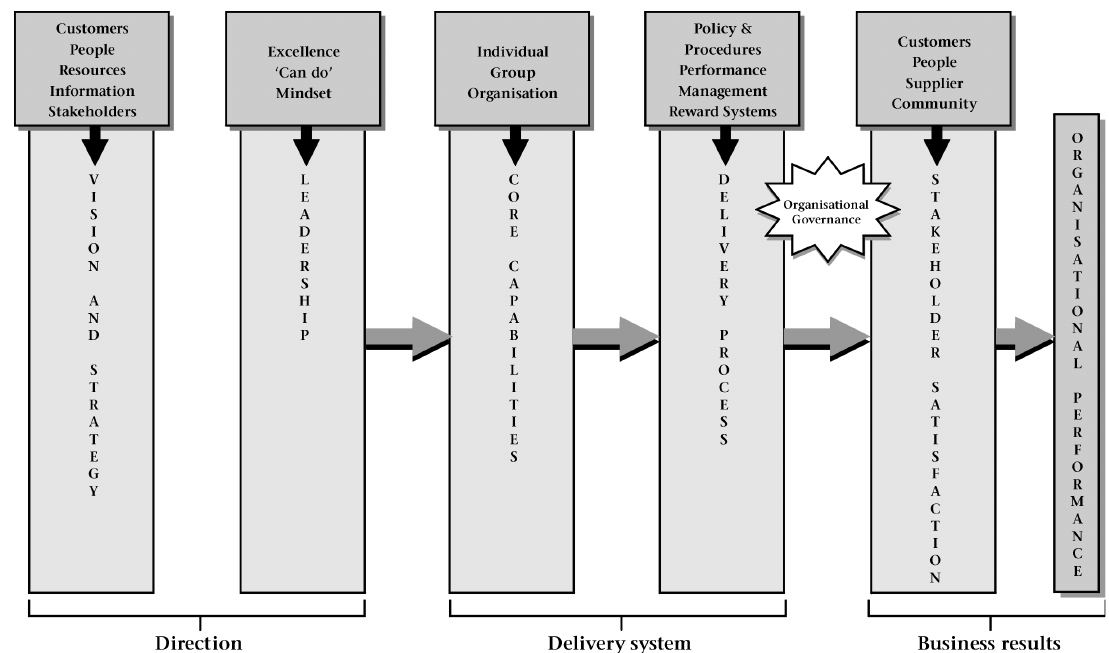
Figure 2: An integrated high performance organisational culture